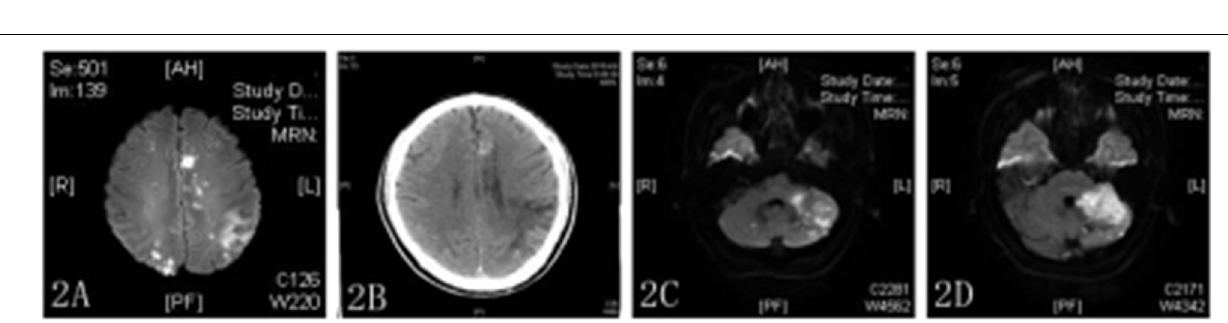
FIGURE 2 | (A,C,D) DWI showed multiple high-density areas in the brain (A) and high-density shadows in bilateral cerebellar hemispheres (C,D) . (B) CT image showing a new high-density